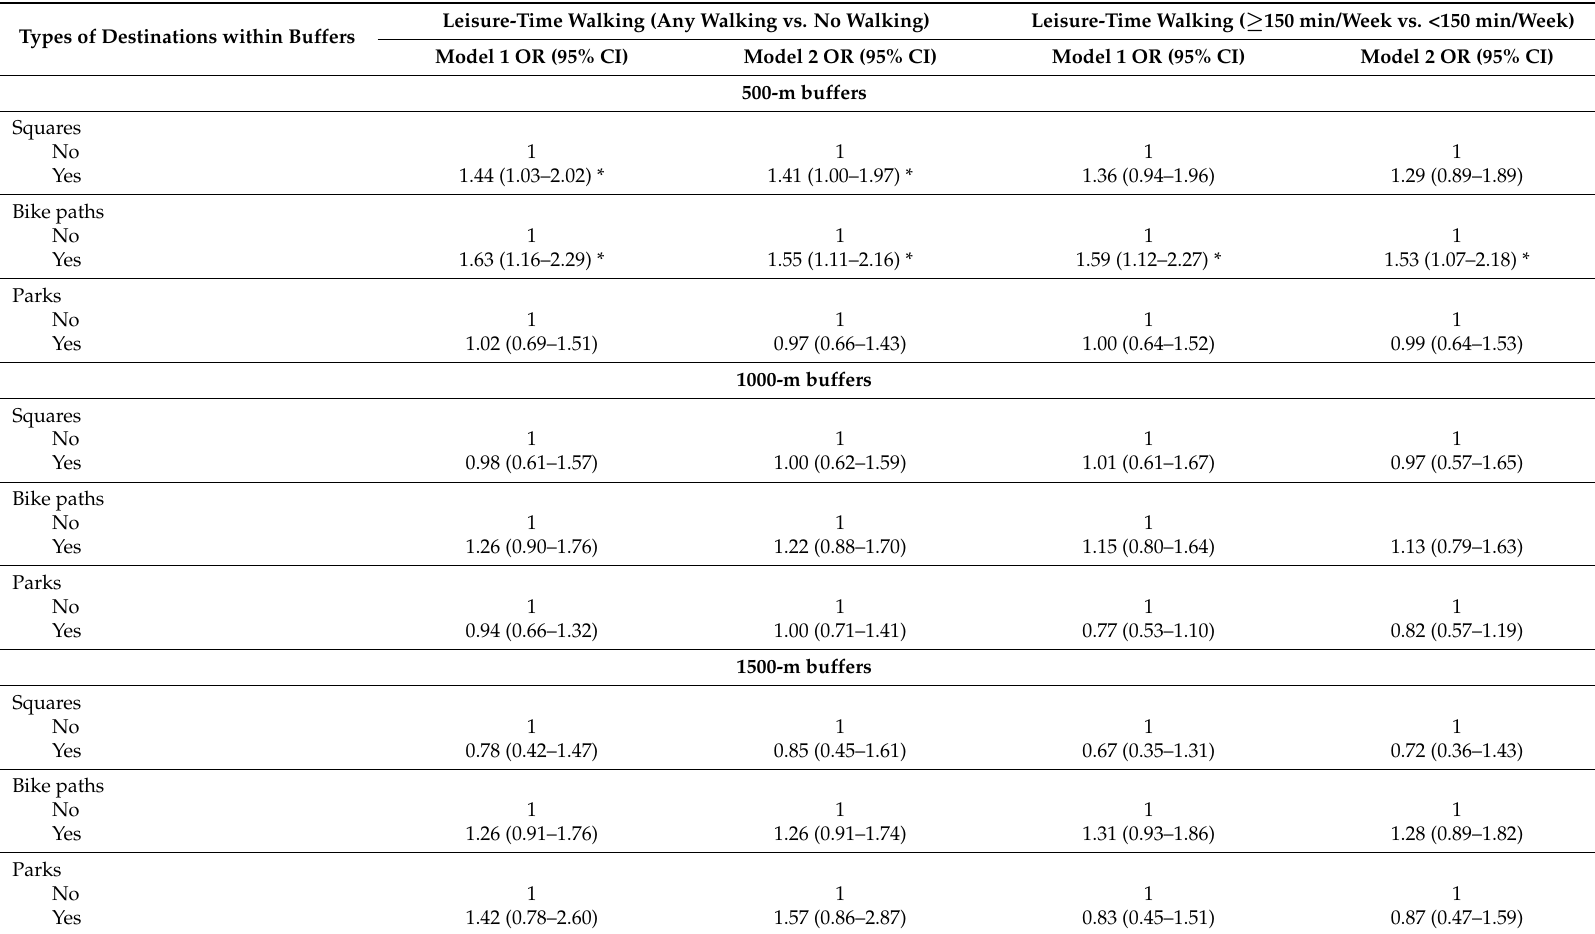
Table 3. Odds ratios (OR) for the association between participating in walking for leisure and types of destinations within buffers of 500 m, 1000 m, and 1500 m. Types of Destinations within